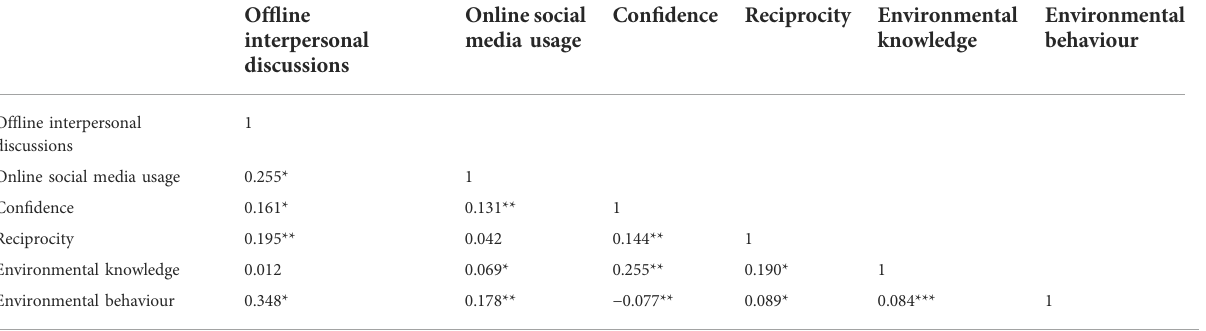
TABLE 2 Correlation coef fi cients between the sample ’ s social media use, interpersonal discussions and each variable. Of fl